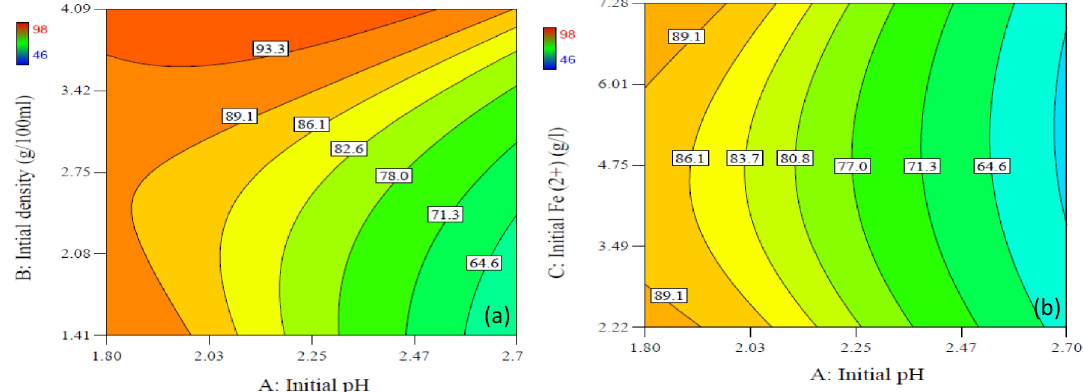
Fig. 3. Contour plots of the interaction effects for Fe recovery: (a) initial pH vs. initial density at a constant initial Fe 2+ concentration of 7.3 g/L, (b) initial pH vs. initial Fe 2+ concentration at a constant initial pulp density of 1.4 g/100